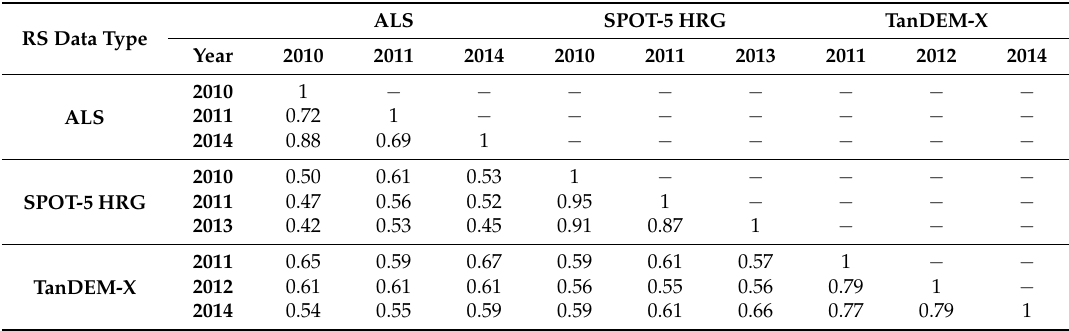
Table C3. Residual correlations between and within three different RS data types in estimating volume per